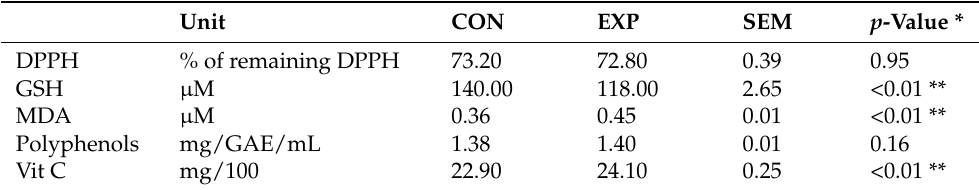
Table 3. The activity of non-enzymatic compounds in ruminal fluid in control and experimental group.